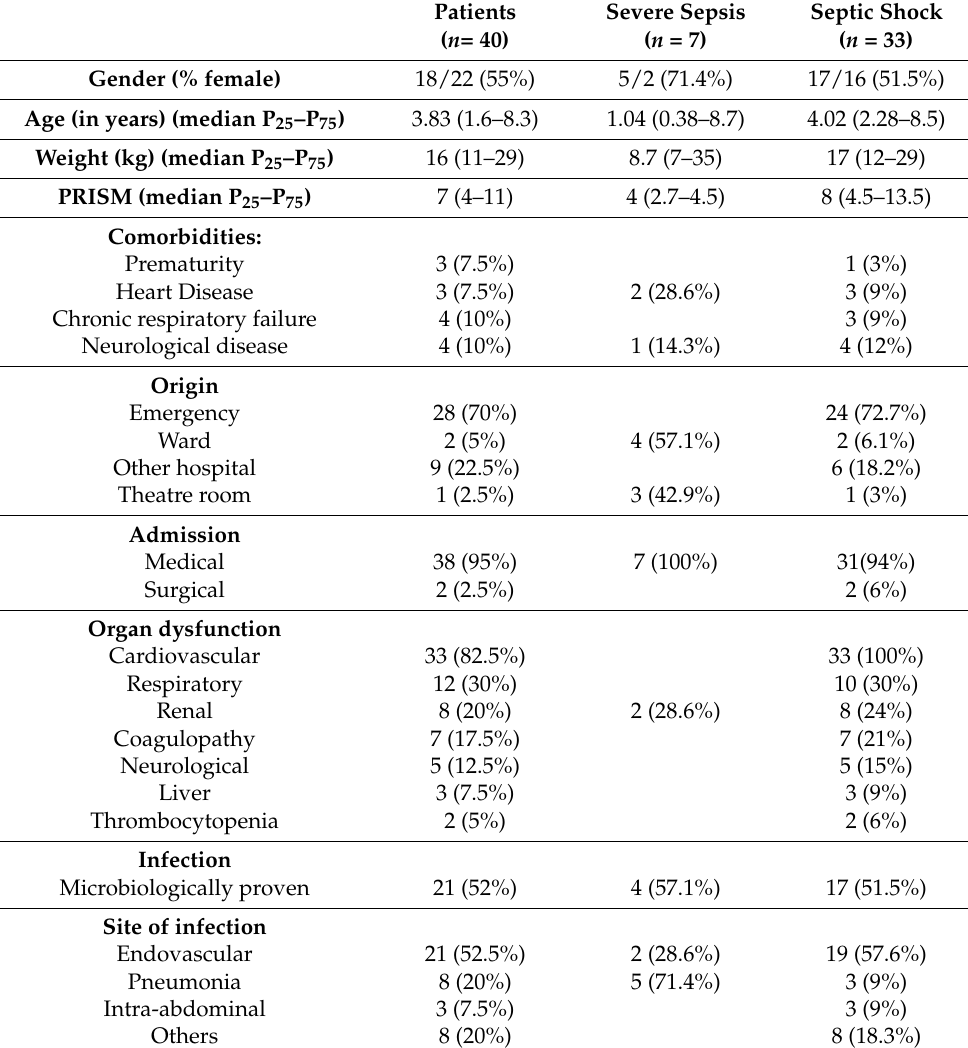
Table 1. Clinical features of patients diagnosed with severe sepsis and septic shock.